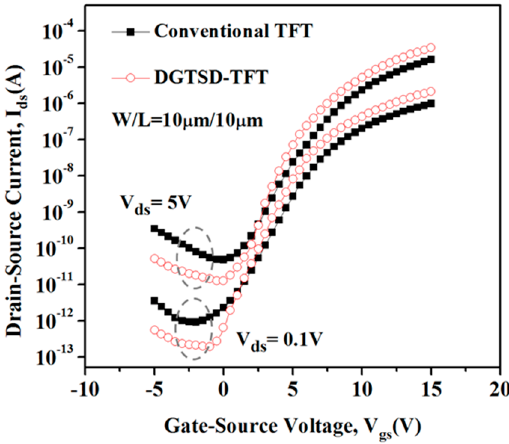
Figure 5. Device transfer characteristics for the double-gate two-step source/drain structure (DGTSD-TFT) and for the conventional single top gate TFT.